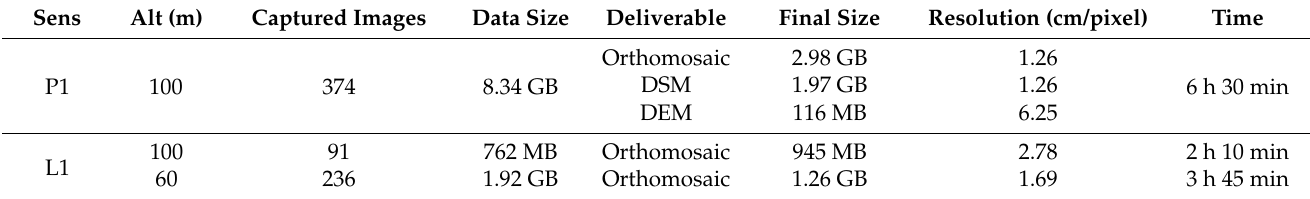
Table 4. Characteristics of deliverables from photogrammetric processing (S f M) of P1 sensor and LiDAR sensor image datasets. Sens: sensor, Alt: flight altitude, Time: processing time for the entire project.